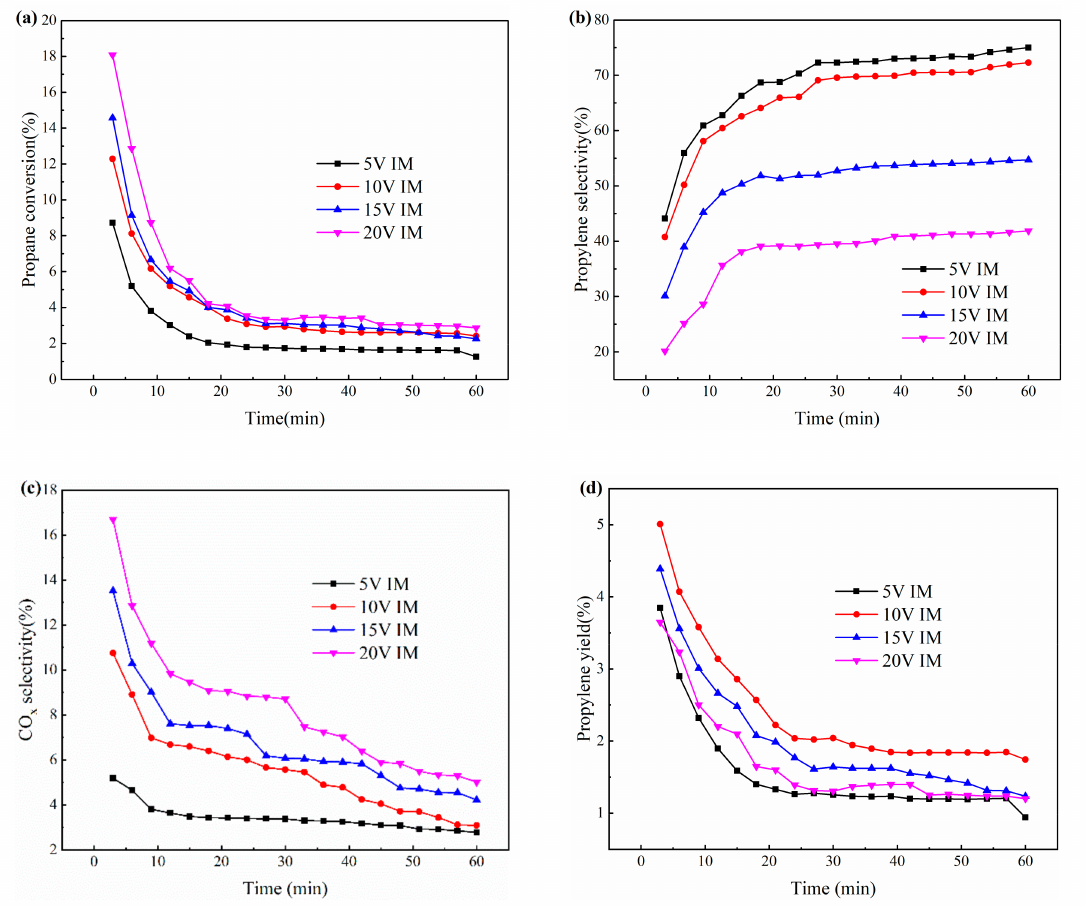
Figure 5. The oxidative dehydrogenation of propane (ODHP) reaction performance for V-based oxygen carriers with different V loadings by impregnation method at 615 ◦ C: ( a ) Propane conversion, ( b ) Propylene selectivity, ( c ) COx selectivity, ( d ) propylene